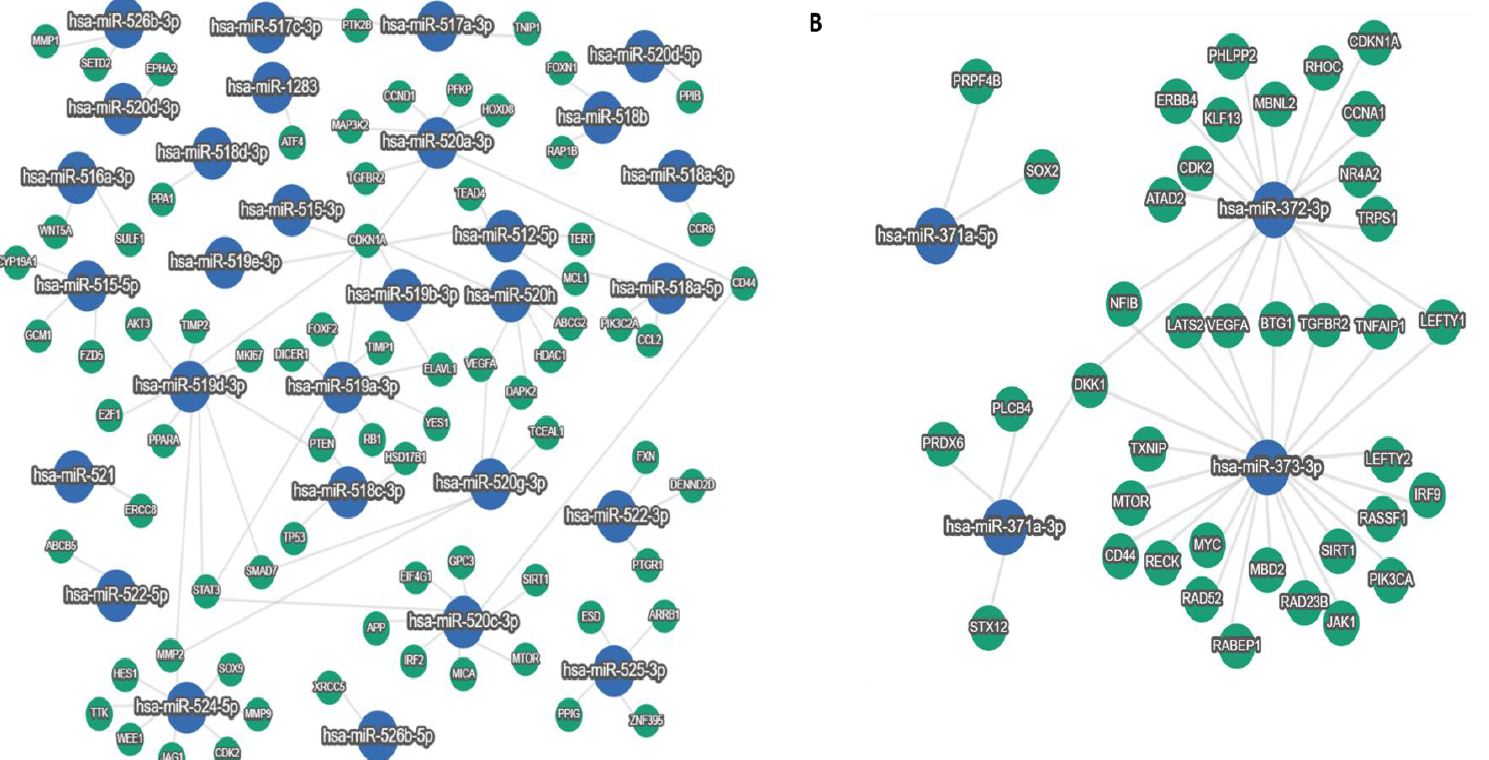
Figure 4. miRNAs–target genes network. Strong interactions are displayed for experimentally validated target genes and the components of the C19MC ( A ) and MIR371-3. ( B ) clusters generated by miRTargetLink 2.0. Network layout: Random. Nodes are represented as circles: miRNAs (blue) and target genes (green).